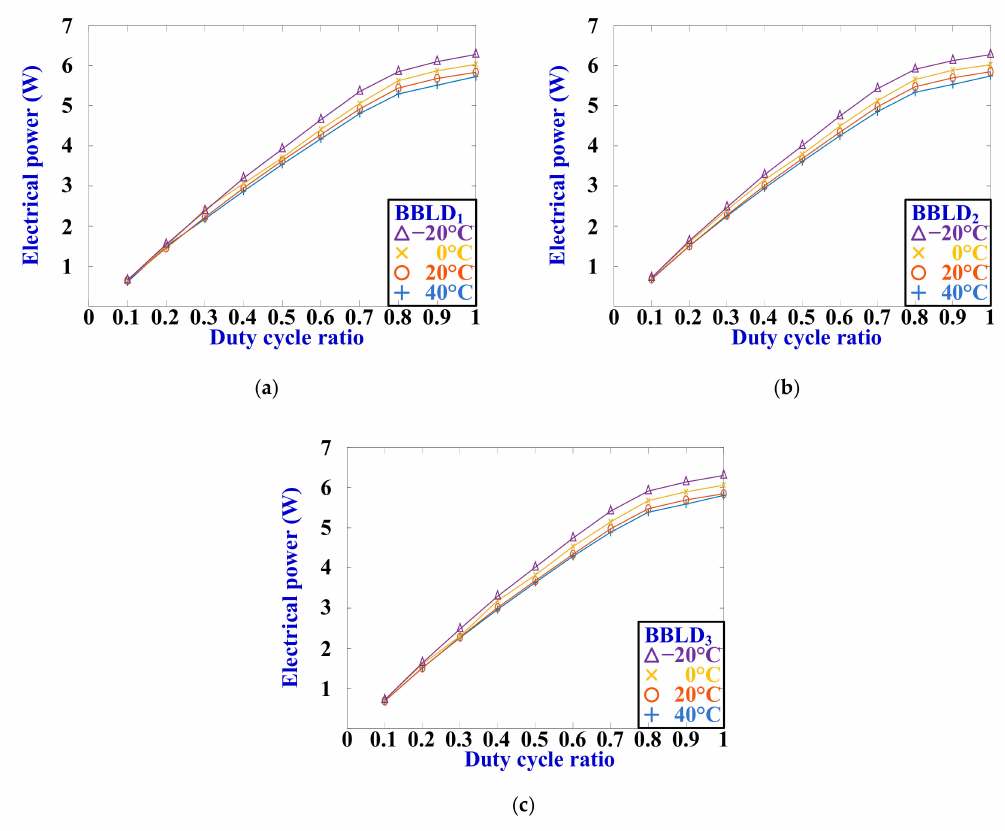
Figure 14. Variation of D pdcm to electrical power ( P e ( pdcm _ rms ) ) using RMS value calculation ( f s = 400 Hz). ( a ) BBLD 1 . ( b ) BBLD 2 . ( c ) BBLD 3